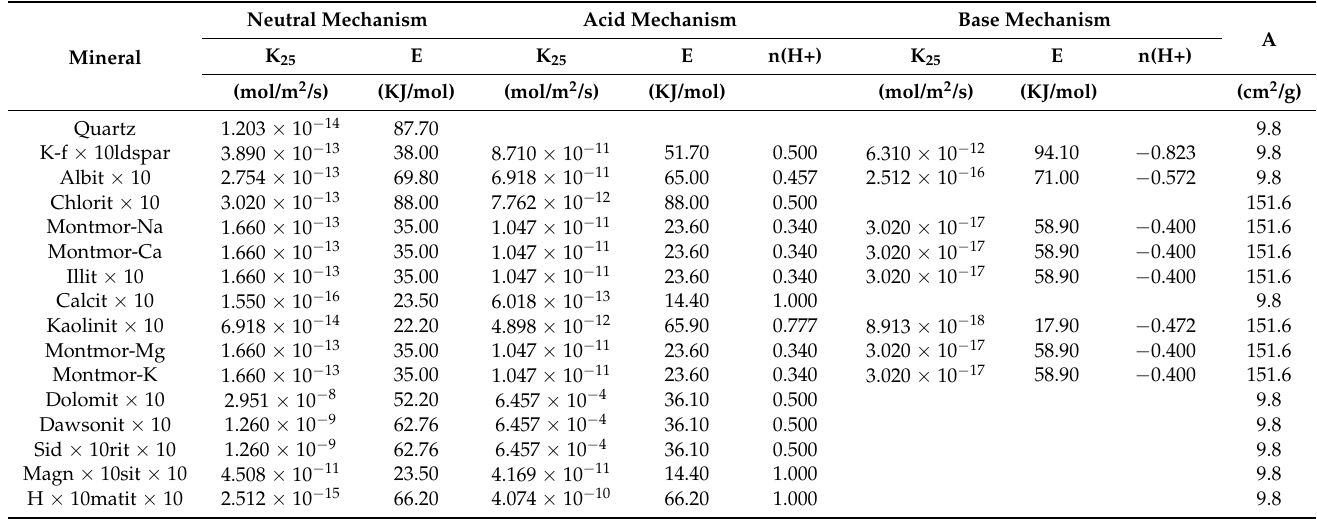
Table 3. Parameters of mineral reaction